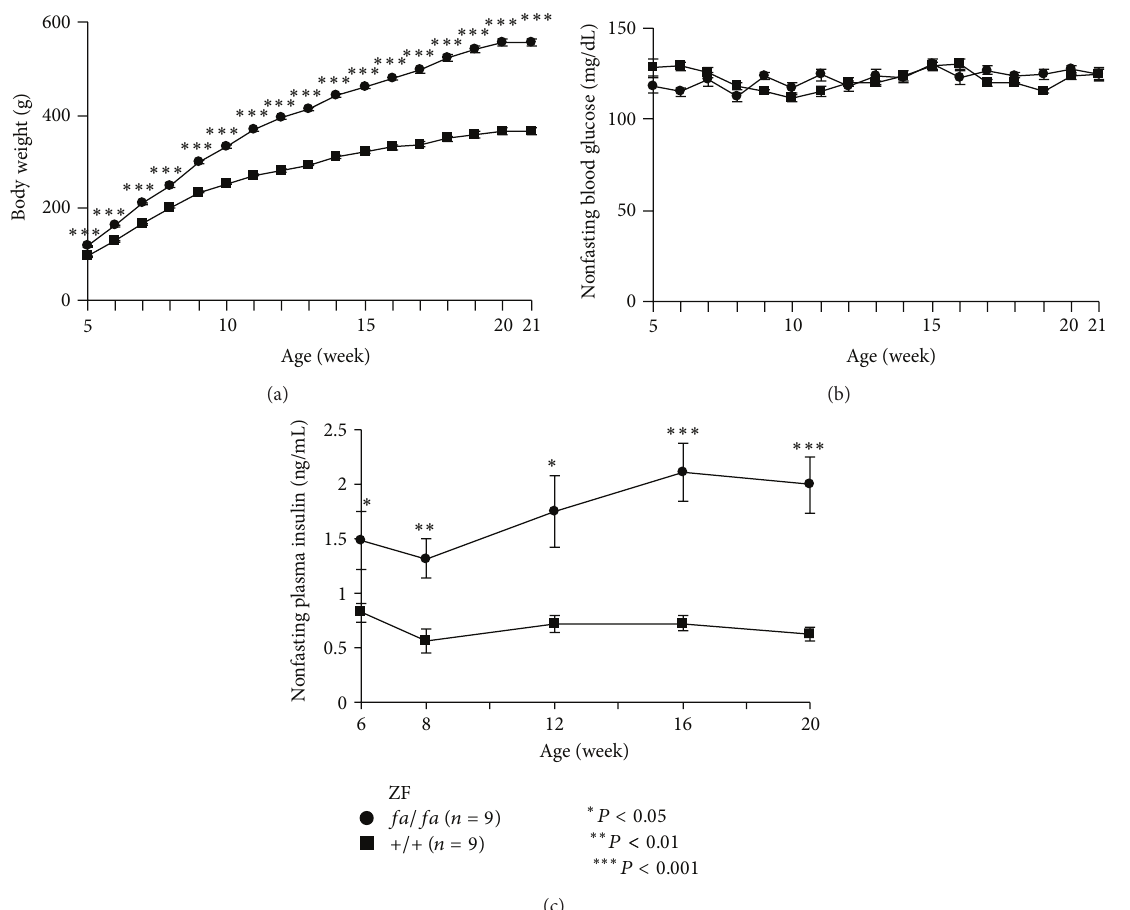
Figure 5: Longitudinal phenotypic characterization of the ZF strain. (a) Body weight, (b) nonfasting blood glucose level, and (c) nonfasting plasma insulin level of fa/fa ( 𝑛 = 9 ) and +/+ ( 𝑛 = 9 ) male rats in the ZF strain. Welch’s t test was used for comparisons between fa/fa and +/+